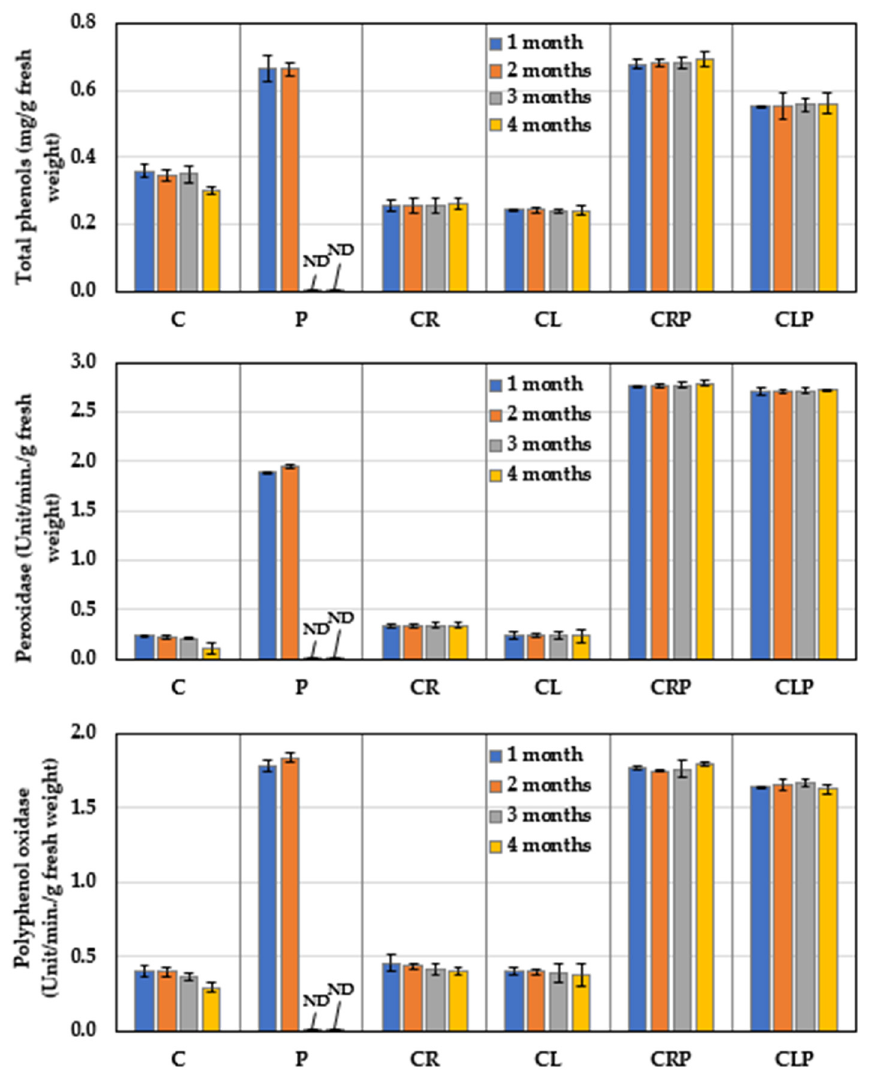
Figure 10. Defense-related phytochemicals of JA tubers treated with essential oils and infected with P. polonicum under storage at 25 ± 2 °C (mean ± SD). C: untreated control; P: untreated infection by P. polonicum (ARS20); CR: treated with caraway oil; CL: treated with clove oil; CRP: treated with caraway oil plus infection by P. polonicum ; CLP: treated with clove oil plus infection by P. polonicum ; ND: not determined due to full deterioration.